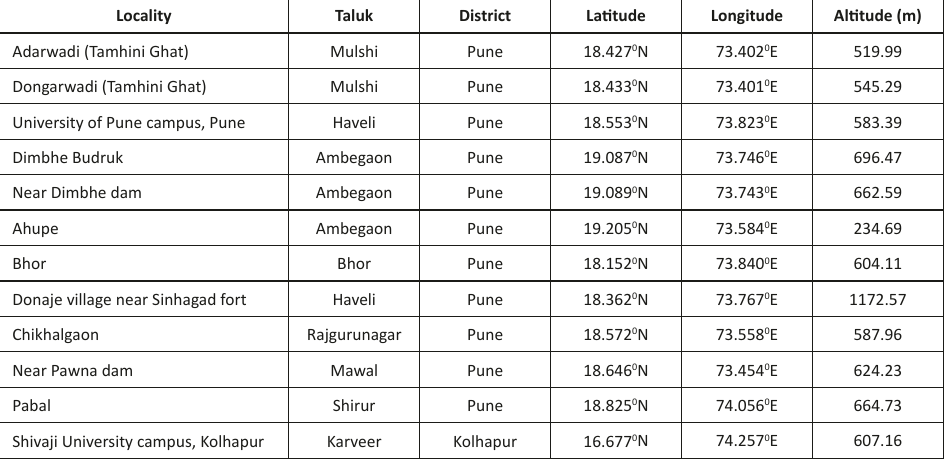
Table 1. Details of collection locations of S. ( Discolia ) fasciatopunctata dunensis in Maharashtra, India. Locality